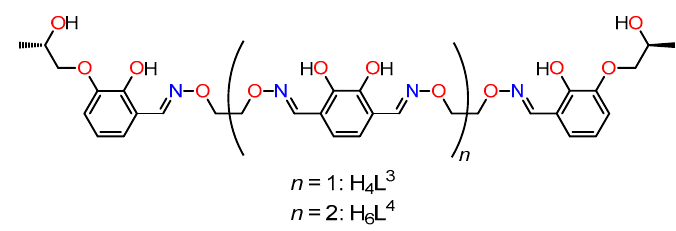
Figure 11. Molecular design of bis ‐ and tris(salamo) ligands, H 4 L 3 and H 6 L 4 , having chiral tethers, ( S ) ‐ 2 ‐ hydroxypropyl groups.